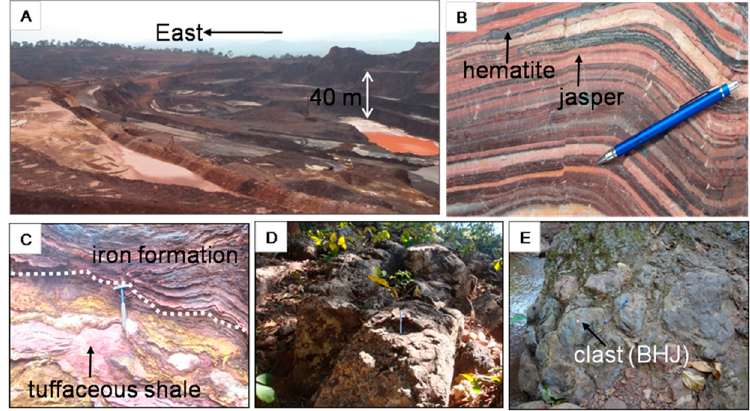
Figure 4. ( A ) Panoramic view of an open pit mining pit at KMIOD; ( B ) close-up view of deformed Banded Hematite Jasper (BHJ) with microfaults and fractures; ( C ) field photograph showing contact zone of tuffaceous shale and thin laminated BHJ; ( D ) mafic volcanic rock; and ( E ) auto-clastic conglomerate exposed along the Karo River.